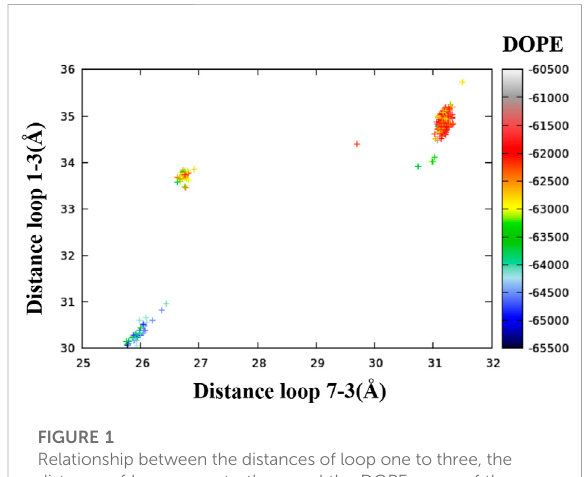
FIGURE 1 Relationship between the distances of loop one to three, the distance of loop seven to three and the DOPE score of the 400